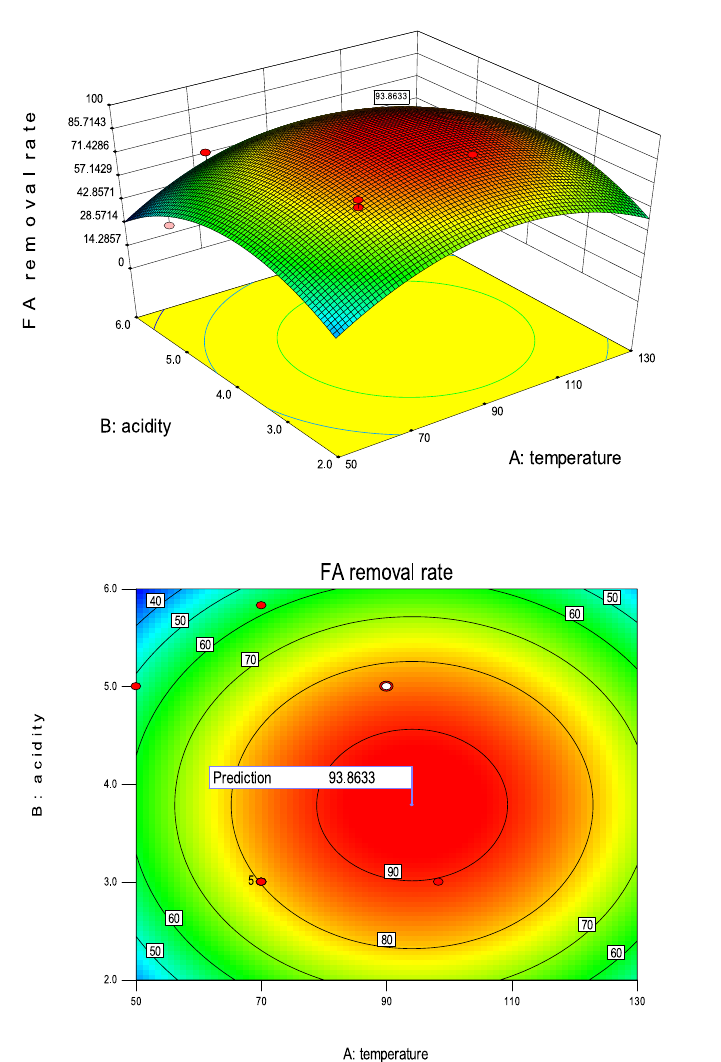
Figure 5. Optimized 3D surface graph and contour plots.